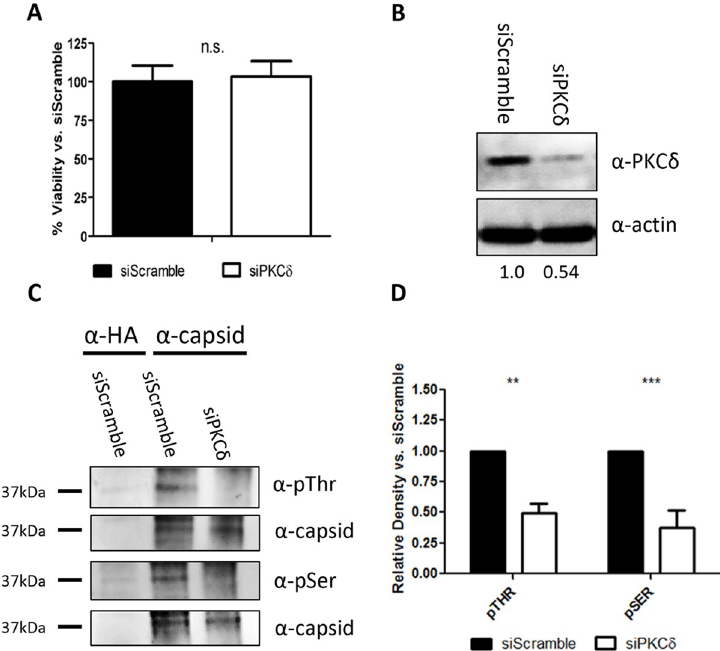
Fig 3. siRNA Knockdown of PKC δ decreases phosphorylation of VEEV capsid. A) U87MG cells were transfected with 50 nM of the indicated siRNA and incubated for 72 hours. Cell viability was measured using Cell Titer-Glo assay from Promega. Luminescence was measured and normalized to siRNA scramble data. Values are average of 8 biological replicates. B) Western blots probing for PKC δ and actin from cell lysates treated with the indicated siRNA. Band density was analyzed on BioRad Quantity One software and normalized to actin. Normalized values were calculated relative to siScramble and values are below the actin blot in their respective lane. Images are representative of 3 biological replicates. C) U87MG cells were transfected with siRNA against PKC δ or a scrambled control and incubated for 72 hours. Cells were transfected with a plasmid expressing the VEEV structural polyprotein and incubated for 48 hours. Cells were collected, lysed, and immunoprecipitated with α -HA or α -VEEV capsid antibodies. Protein complexes were bound to Protein G Dynabeads, samples were run on SDS-PAGE, and western blot analysis was performed for phospho-Ser or phospho-Thr residues. D) Western blot band density was analyzed on BioRad Quantity One software and normalized to capsid. Normalized values were calculated relative to siScramble transfected cells. Quantitation was performed for 3 biological